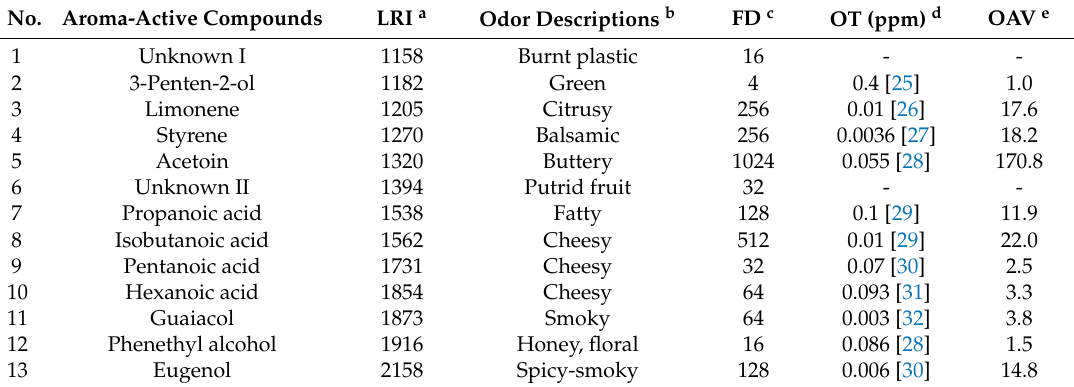
Table 2. Aroma-active compounds of black cumin seed extract (FD ≥